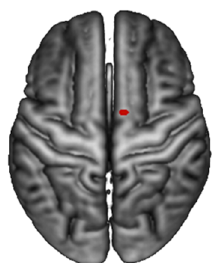
Figure 4. Activation of the SMA: Identity by phase interaction effect (SELF/OTHER vs. PRE/POS).